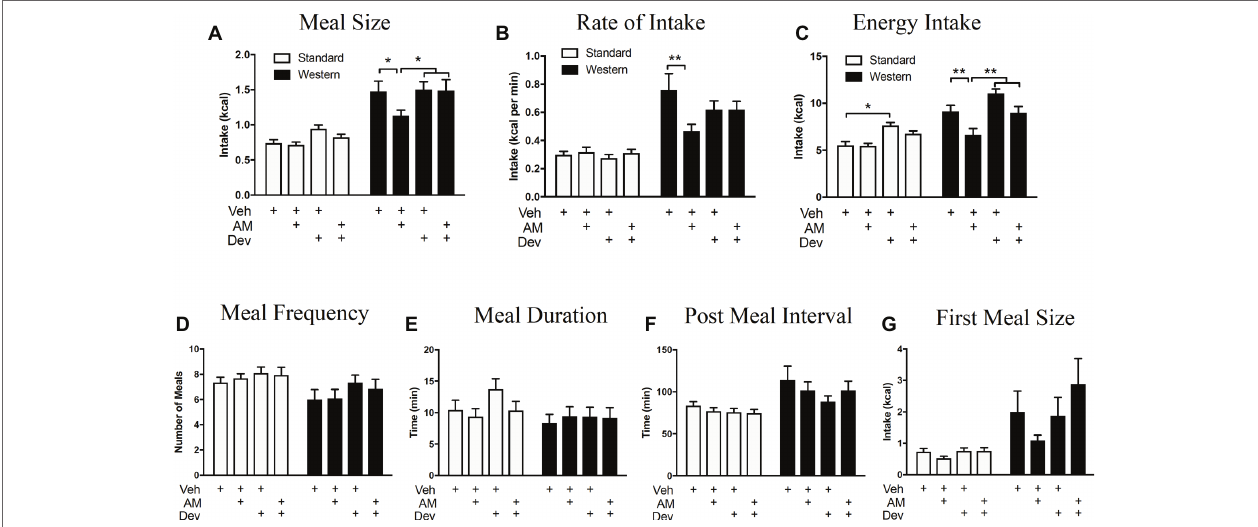
FIGURE 6 | Peripheral eCB signaling drives hyperphagia in mice maintained on a WD via a CCK-dependent mechanism. Caloric intake (A) , meal size (B) , and rate of intake (C) of a western diet (closed bars) are significantly reduced during a 12 h test following inhibition of peripheral CB 1 Rs with AM6545 (AM, 10 mg per kg), an effect absent in low-fat chow fed mice (open bars) and that is blocked by co-administration with the CCK A receptor antagonist, devazepide (Dev; 0.1 mg per kg). Diet and drug had no effect on meal frequency (D) , meal duration (E) , post meal interval (F) , or first meal size (G) . All data represented as means ± SEM. Analyzed using regular 2-Way ANOVA with post hoc Newman-Keuls multiple comparison’s test. n = 11–12 per condition, * p < 0.05, ** p < 0.01.